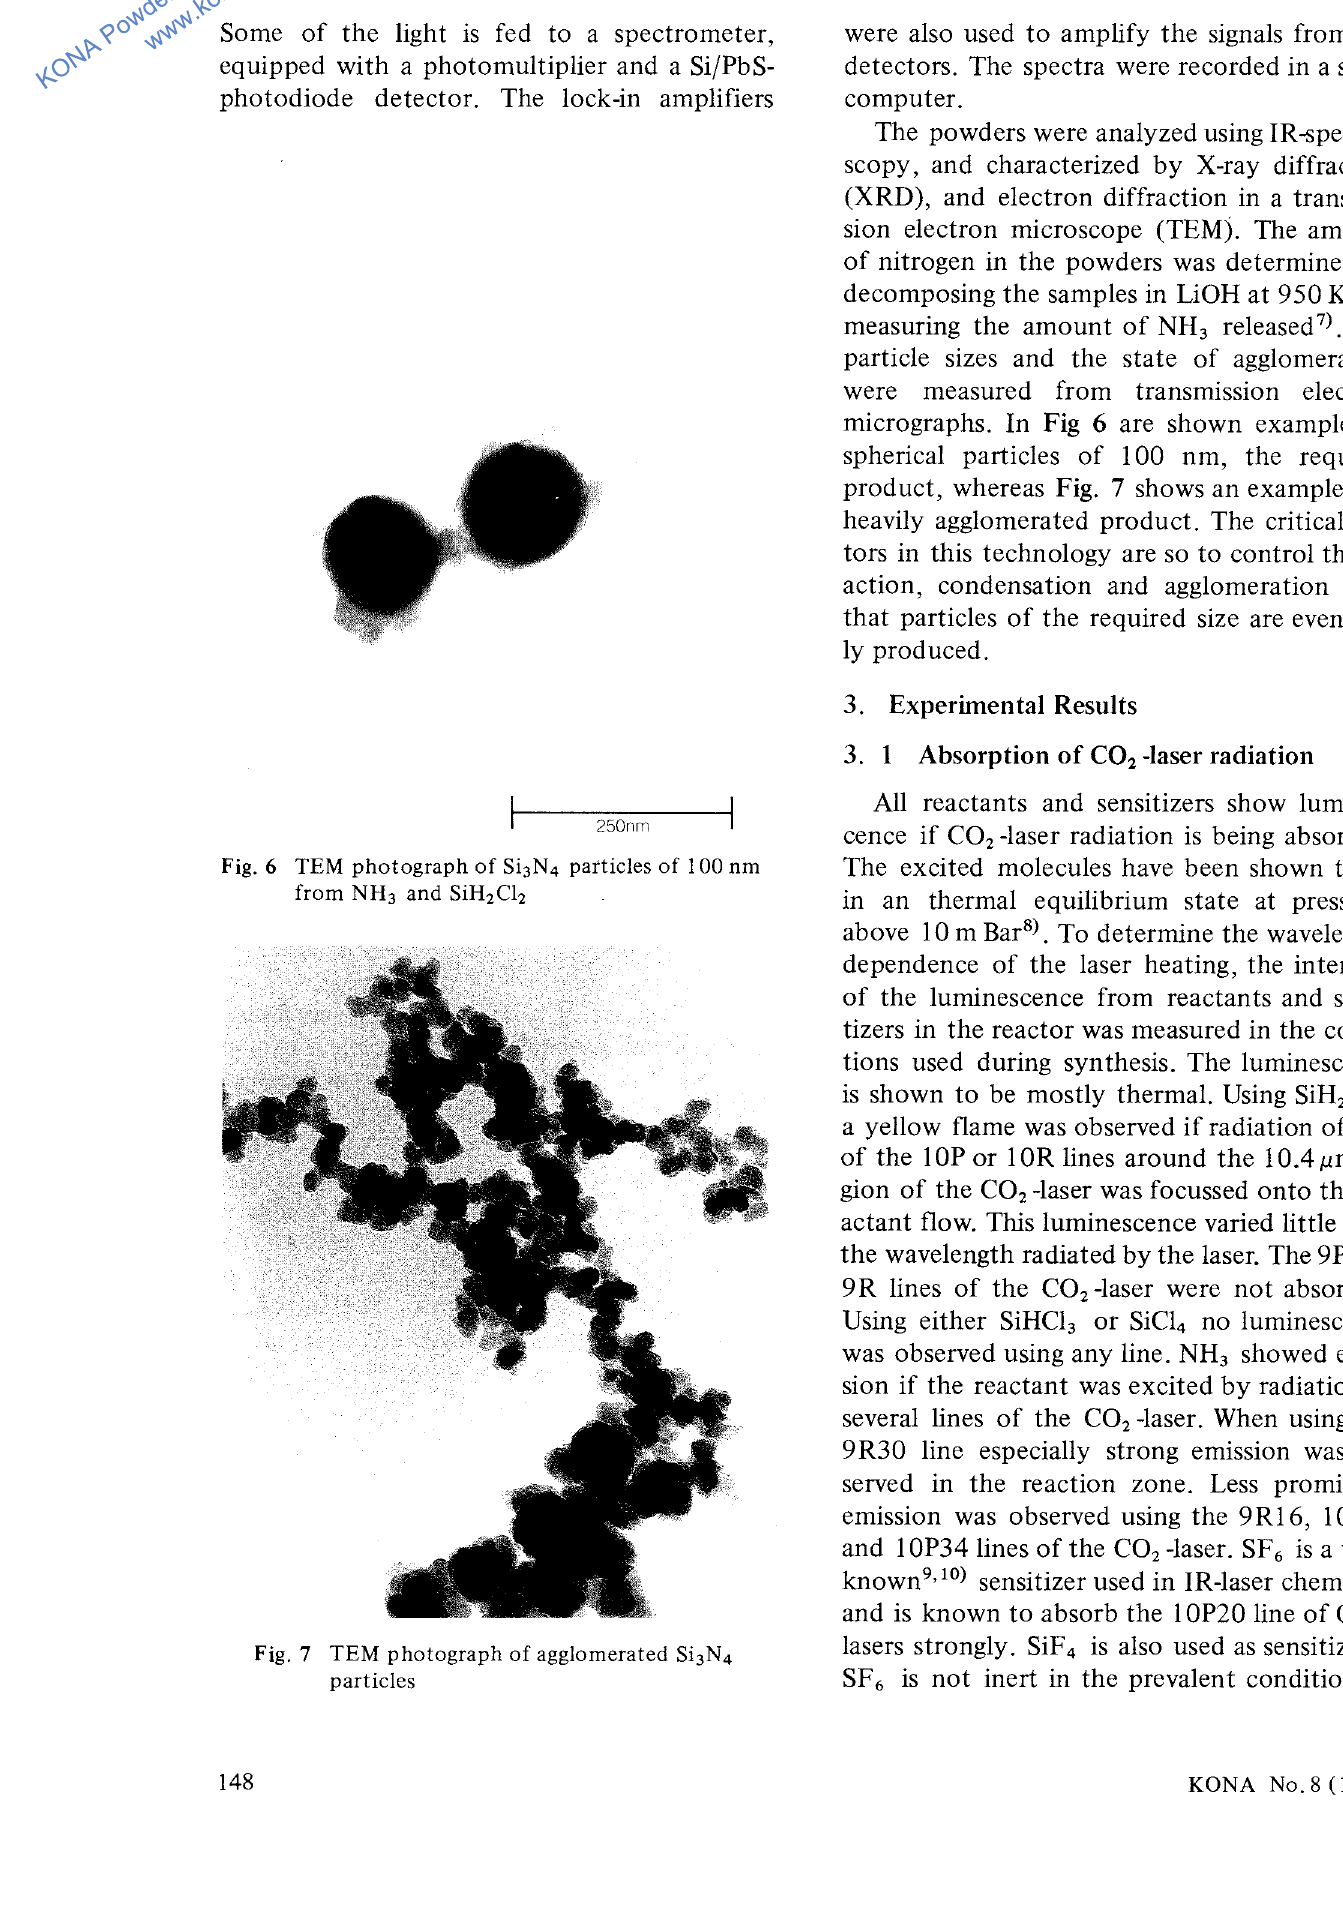
Fig. 7 TEM photograph of agglomerated Si